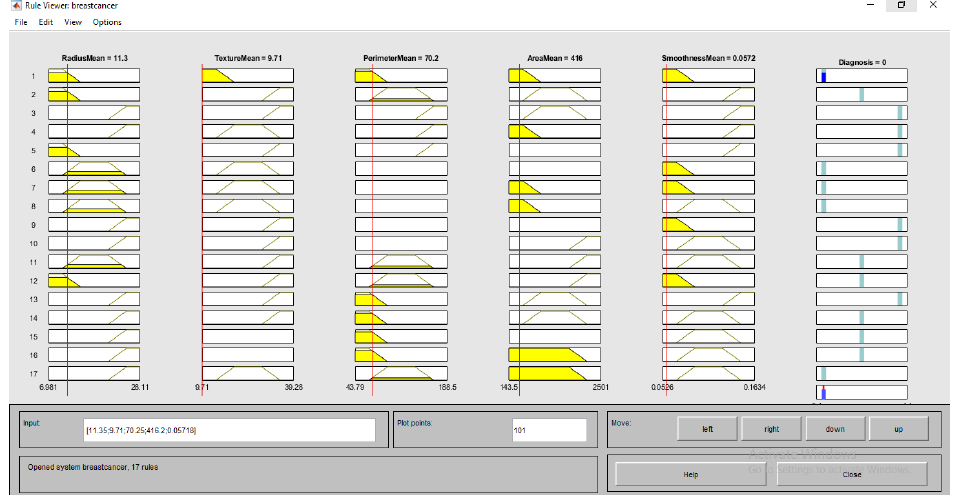
Figure 24. Diagnosis for mild cases.